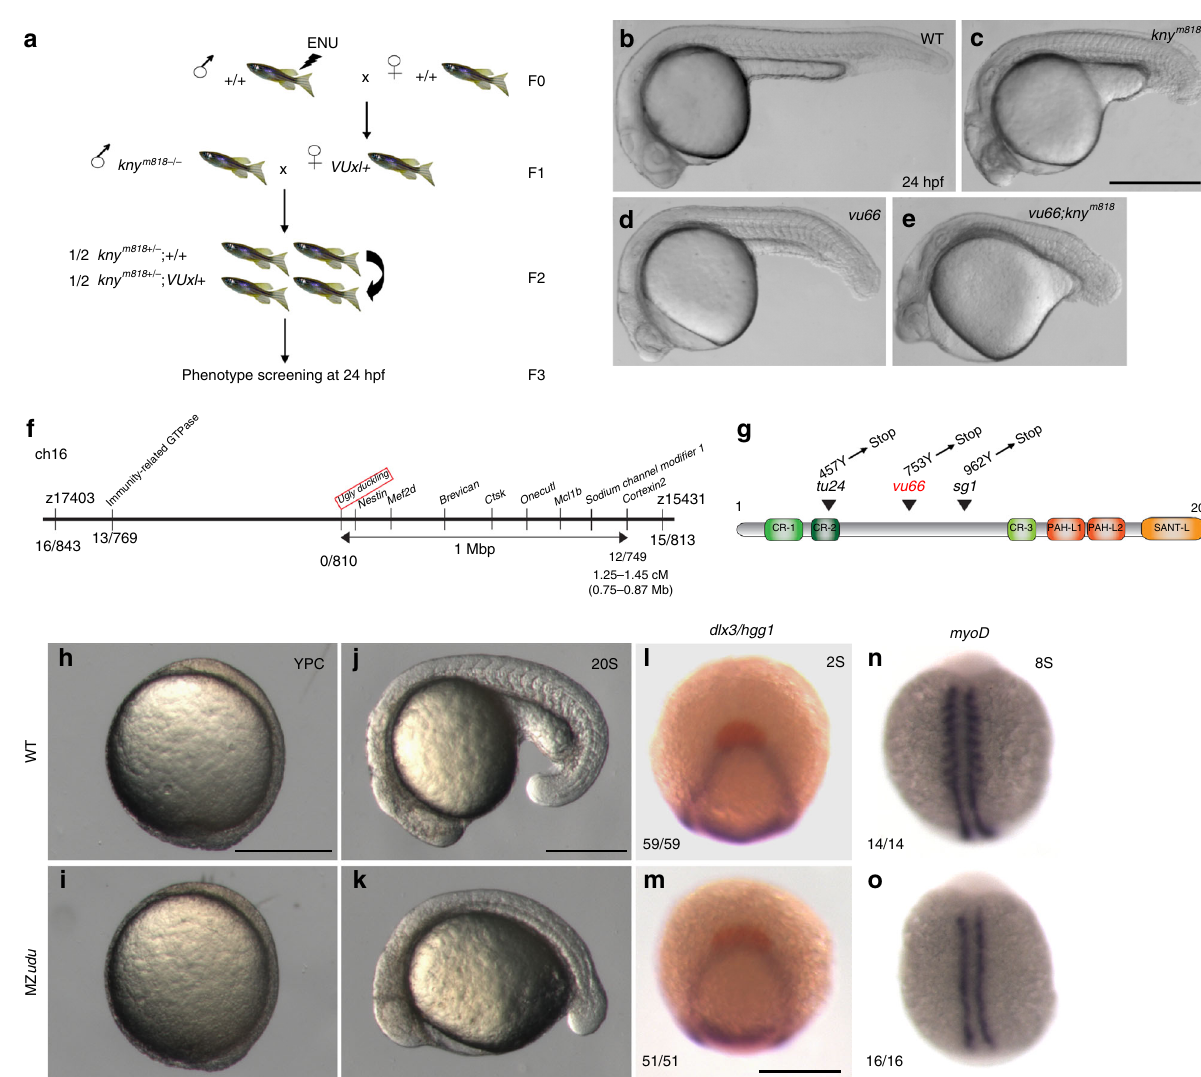
Fig. 1 A forward genetic screen identi fi es ugly duckling ( udu ) /gon4l as a regulator of axis extension in zebra fi sh embryos. a Schematic of a synthetic screen to identify enhancers of the short axis phenotype in kny m818/m818 zebra fi sh mutants. b – e Phenotypes at 24 hpf: wild type (WT) ( b ), kny m818/m818 ( c ), vu66/ vu66 ( d ), kny m818/m818 ; vu66/vu66 compound mutants ( e ). Images are representative of phenotypes observed at Mendelian ratios in multiple independent clutches. f Diagram of mapping vu66 mutation to Chromosome 16. Bold numbers below specify the number of recombination events between vu66 and the indicated loci. g Diagram of the Gon4l protein encoded by the udu locus. Arrowheads indicate residues mutated in vu66 and other described udu alleles. h – k Live WT ( h , j ) and maternal zygotic (MZ) udu ( i , k ) embryos at yolk plug closure (YPC) ( h – i ) and 20 somite stage ( j – k ). 100 percent of MZ udu mutants from more than 15 germline-replaced females exhibited the pictured phenotypes. l – m Whole mount in situ hybridization (WISH) for dlx3 (purple) and hgg1 (red) in WT ( l ) and MZ udu − / − ( m ) embryos at two-somite stage. n – o WISH for myoD in WT ( n ) and MZ udu − / − ( o ) embryos at eight-somite stage. Anterior is to the left in b – e , j – k ; anterior is up in h – i , l – o . Fractions indicate the number of embryos with the pictured phenotype over the number of embryos examined. Scale bar is 500 μ m in b – e and 300 μ m in h – the anti-apoptotic mitochondrial protein Bcl-xL 30 did not sup- higher in MZ udu − / − than in WT gastrulae at all-time points press their short axis phenotype (Supplementary Fig. 3a-f) as (Fig. 2e, two-way ANOVA p < 0.0001), indicative of decreased udu-gfp RNA did (Supplementary Fig. 3g-i). These results straightness. Interestingly, laminin was detected by immunos- demonstrate a speci fi c role for Gon4l in axial extension during taining at the notochord boundary of both WT and MZ udu − / − gastrulation. embryos (Fig. 2f, g), indicating that MZ udu mutants form a bona fi de boundary, albeit an irregular one. These results demonstrate that Gon4l is necessary for proper formation of the notochord Gon4l regulates formation of the notochord boundary . Time- boundary during gastrulation. lapse Nomarski (Fig. 2a, b) and confocal (Fig. 2c, d) microscopy of dorsal mesoderm in MZ udu − / − gastrulae revealed reduced Cell polarity and intercalation are reduced in MZ udu mutants . de fi nition and regularity of the boundary between axial and paraxial mesoderm, hereafter referred to as the notochord In vertebrate gastrulae, C&E is achieved chie fl y through ML boundary, compared to WT (Fig. 2a, b, arrowheads). The ratio of intercalation of polarized cells that elongate and align their the total/net length of notochord boundaries was signi fi cantly cell bodies with the ML embryonic axis 3,5,7,9 . To determine